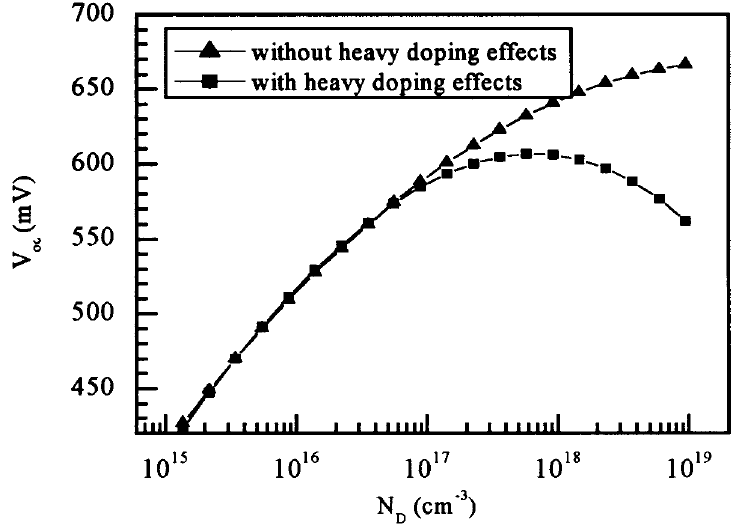
FIGURE 1 Variation of the open circuit voltage of the n þ p silicon solar cells with respect to the level doping N